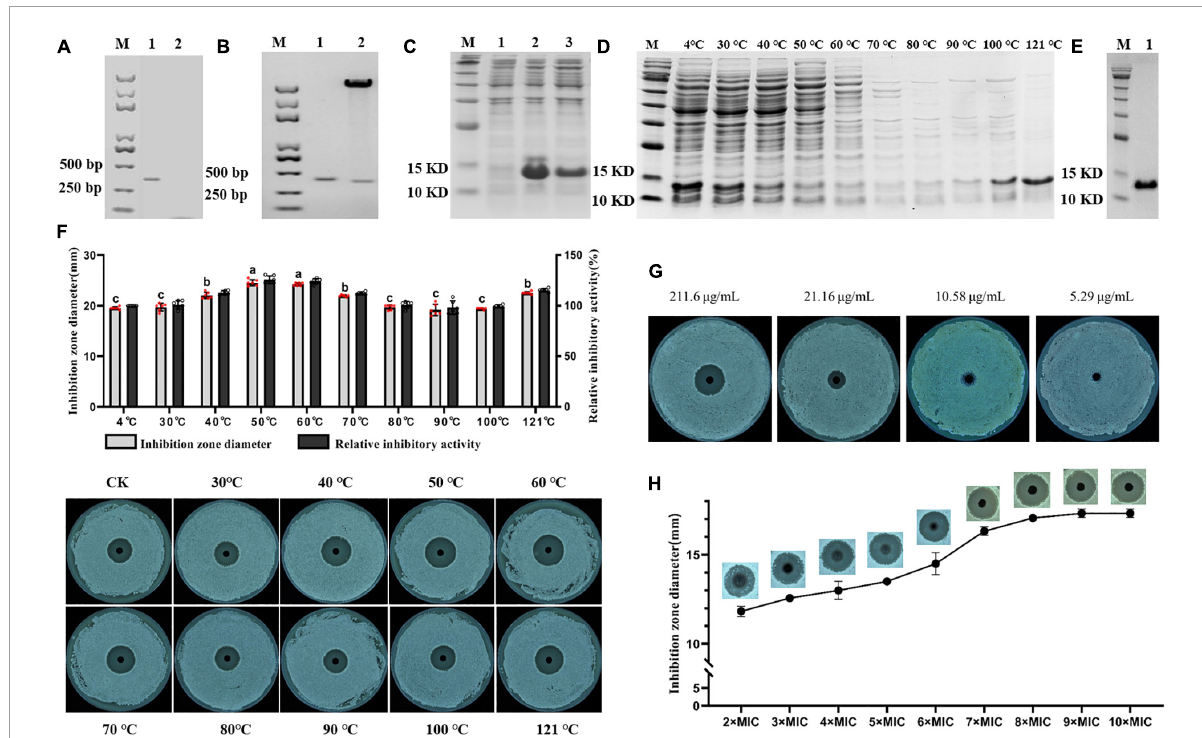
FIGURE2 Obtain of Lcn972 and its antibacterial activity. (A) Obtaining of Lcn972. Lane 1, Lcn972; Lane 2, control; (B) double-digestion verification. Lane 1, Lcn972; Lane2, double digestion of pET-30a-Lcn972; (C) expression of Lcn972. Lane 1, before expression of Lcn972; Lane 2, after expression of Lcn972; Lane 3, total protein containing Lcn972; (D) total protein containing Lcn972 purified by heating; (E) Lcn972 purified by nickel column; (F) antibacterial activity of total protein containing Lcn972 on Streptomyces scabies HP4 after heating; (G) minimum inhibitory concentration (MIC) of Lcn972 against S. scabies HP4, (H) optimal inhibitory concentration of Lcn972 against S. scabies HP4. Letters on the graph denote statistically significant differences (ANOVA, P < 0.05).